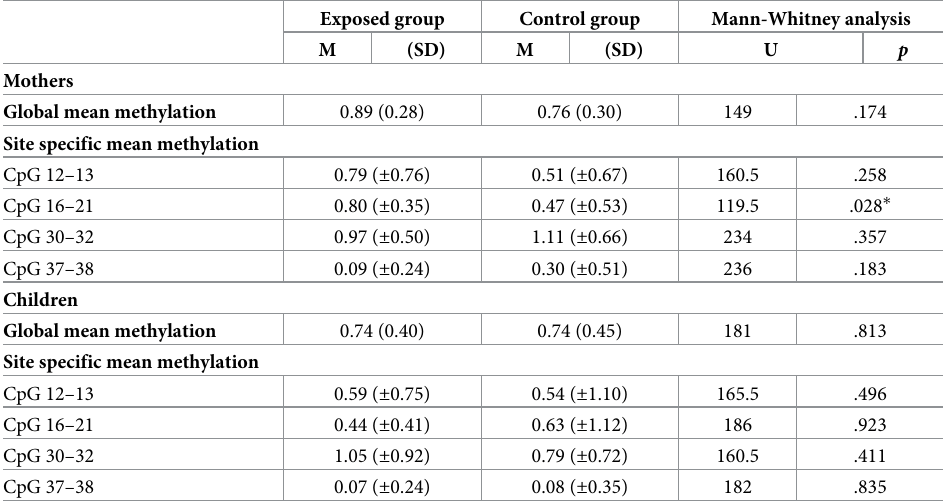
Table 2. Mean and site-specific DNA methylation comparison across groups of mothers and children. Exposed